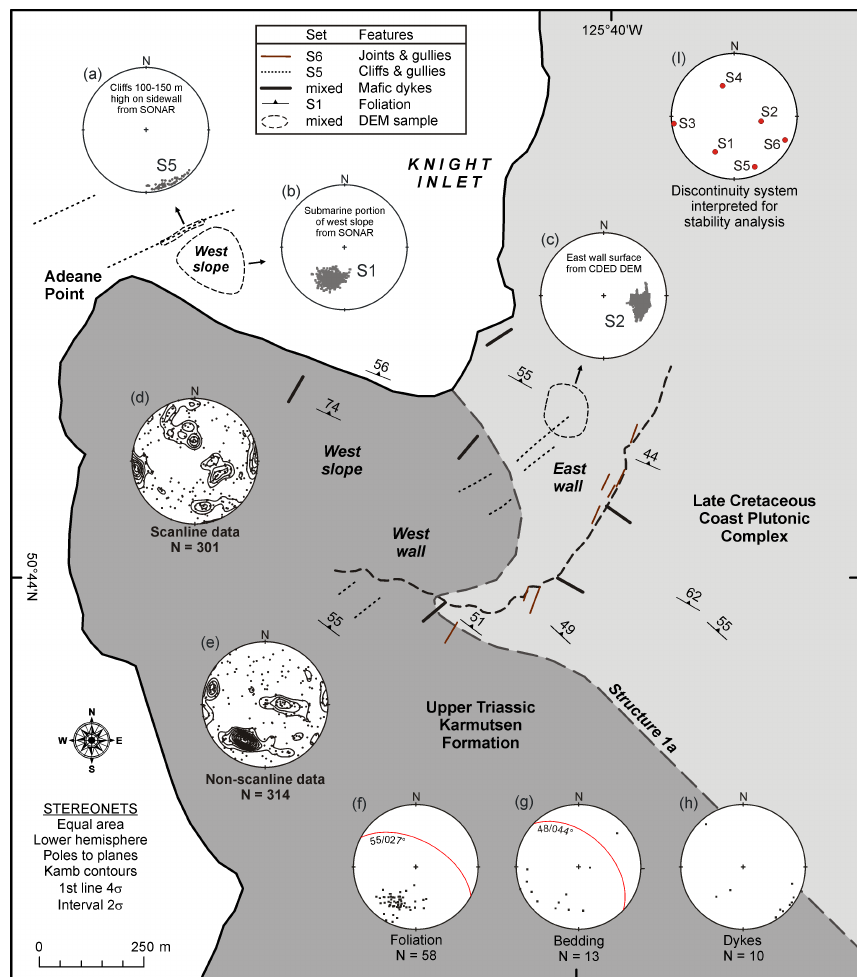
Figure 9. Synthesis of field and remotely sensed structural